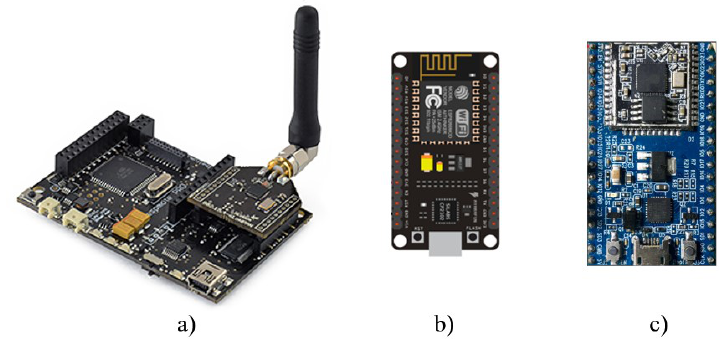
Figure 3. Microcontroller boards: ( a ) Waspmote; ( b ) ESP8266; ( c )